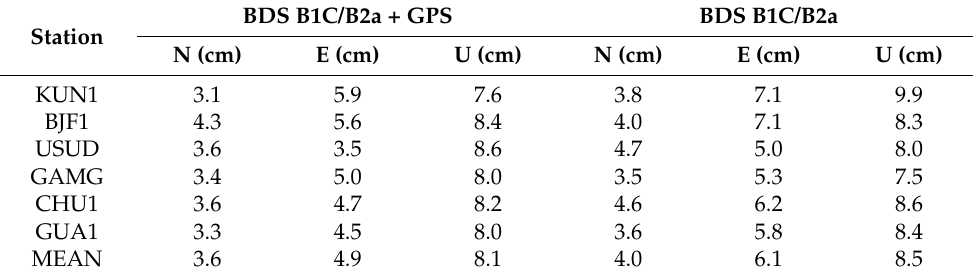
Table 9. Mean RMS values of PPP-B2b kinematic positioning at each station using B1C/B2a.